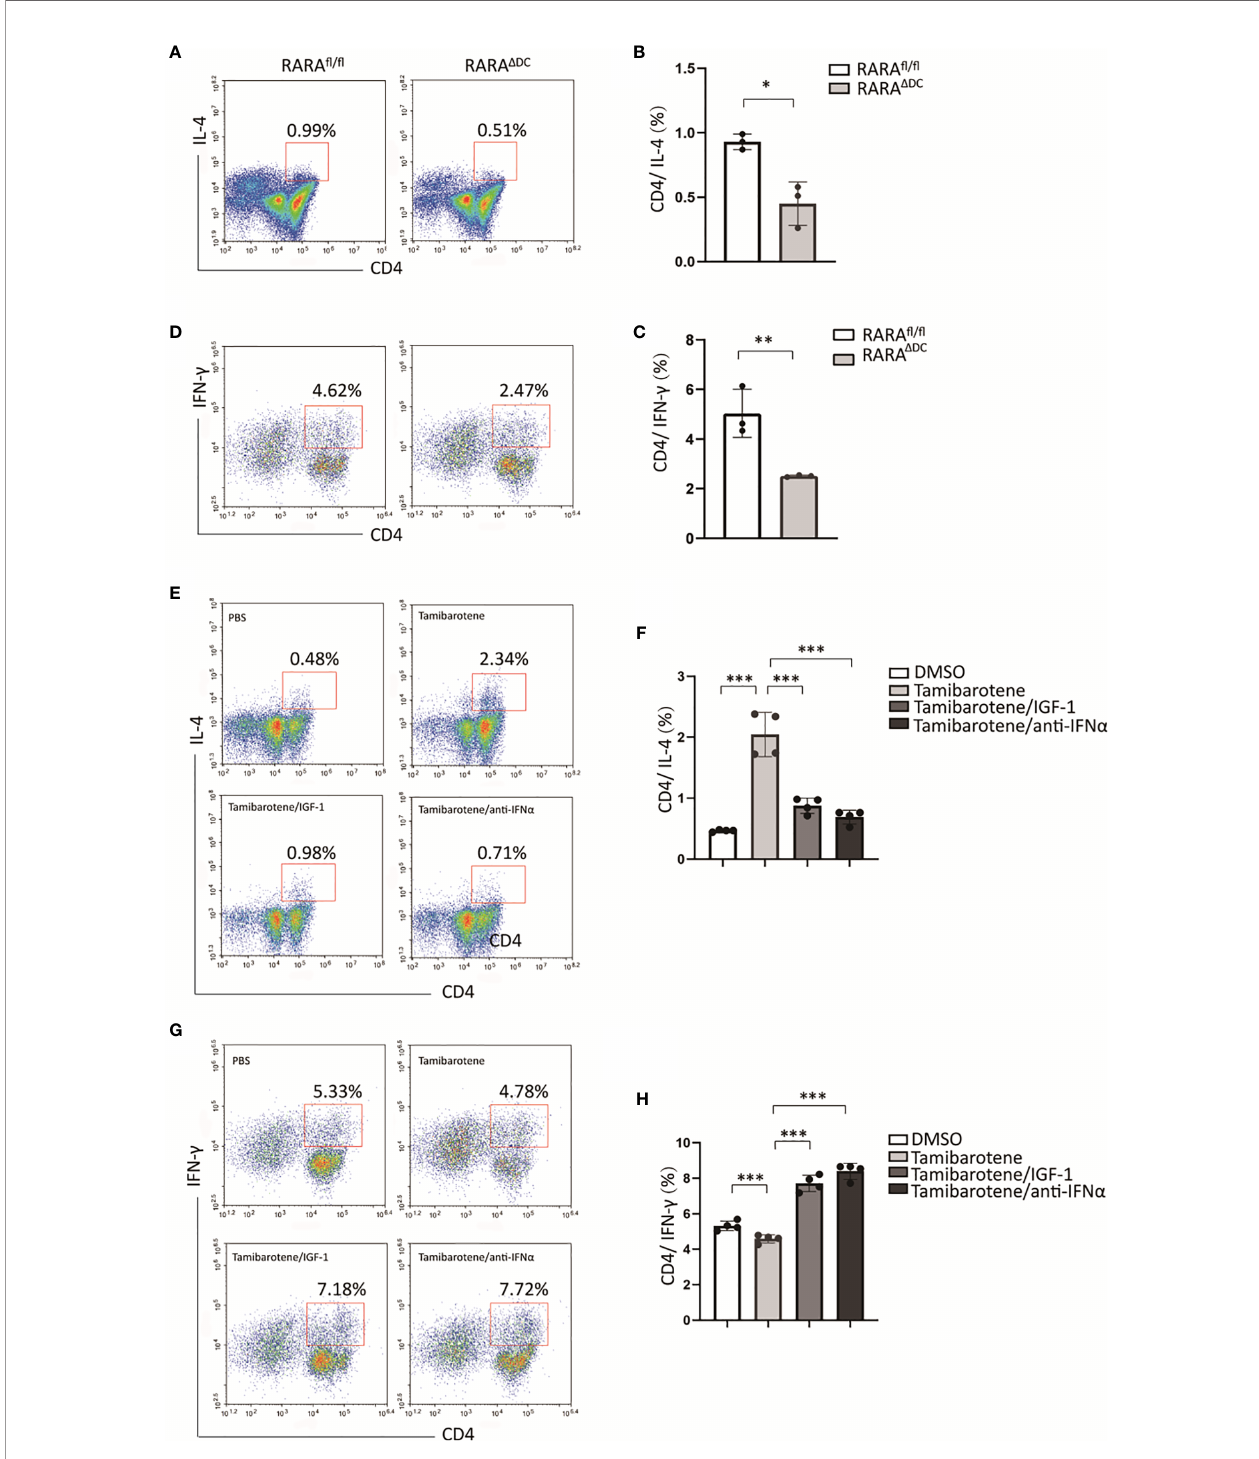
FIGURE 5 | IGF-1 suppresses Th2 differentiation instructed by RAR a -activated BMDC. (A – D) After BMDCs from RAR a fl / fl or RAR a D DC mice co-cultured with naive T cells isolated from B6 mice, the percentage of CD4(+)IL-4(+) T cells and CD4(+)IFN- g (+) T cells were detected by fl ow cytometry.(E-H) BMDCs from B6 mice were treated with DMSO, Tamibarotene, IGF-1 or anti-IFN a , and then co-cultured with naïve T cells. Percentage of CD4(+)IL-4(+) cells and CD4(+)IFN- g (+)were measured by fl ow cytometry. Data are from at least two independent experiments. Graph shows mean and SEM. Data were analyzed by unpaired Student ’ s t-test (A – D) and one-way ANOVA (E – H) . *p < 0.05, **p < 0.01, ***p <